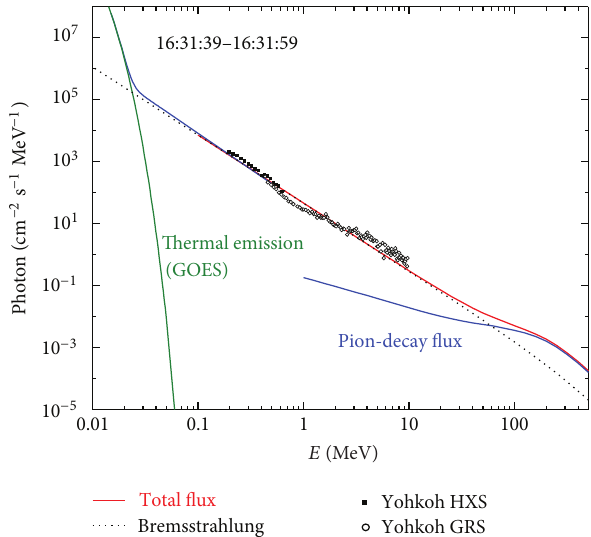
Figure3:CombinedspectrumoftheAugust25,2001,flare.Thetotal flux (blue curve) was restored from CORONAS-F data, the pion- decay flux—from SONG data.